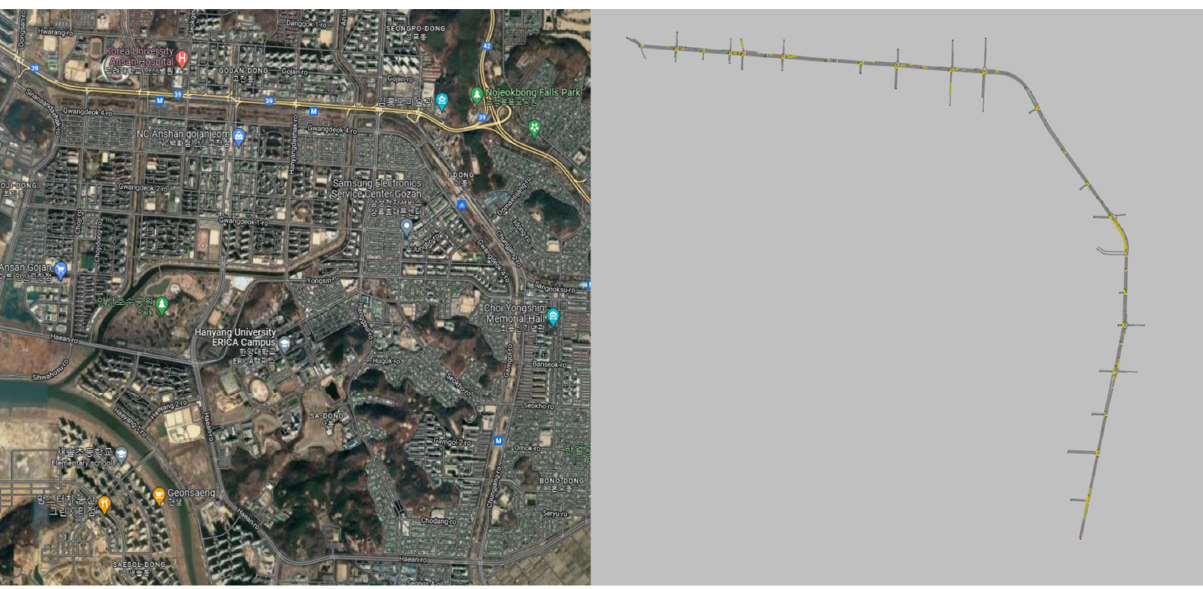
Figure 3. Simulation